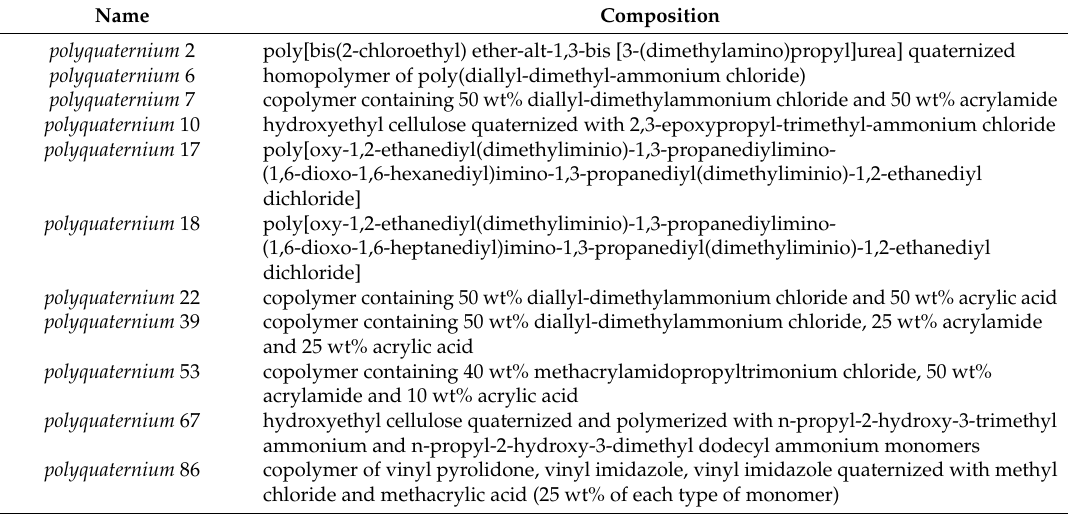
Table 2. Summary of some of the most common polycations found in